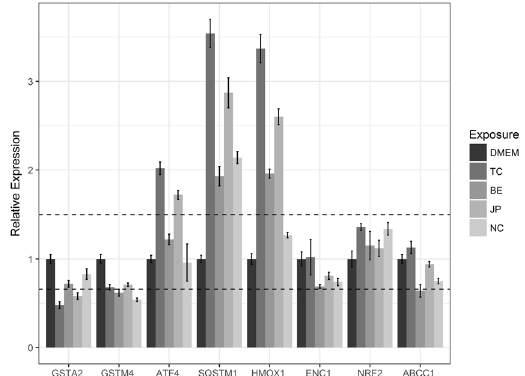
Figure 2. qPCR results for Nrf2 Pathway genes predicted using biclustering algorithm. The plot shows the relative gene expression level (control vs treatment) of several genes associated with Nrf2 pathway. The line represents the fold change cut-off limits (1.5 for up regulation and 0.6 for down regulation). TC indicates Turkish coffee, BE indicates Brasil Espirito, JP indicates Java Preanger and NC indicates